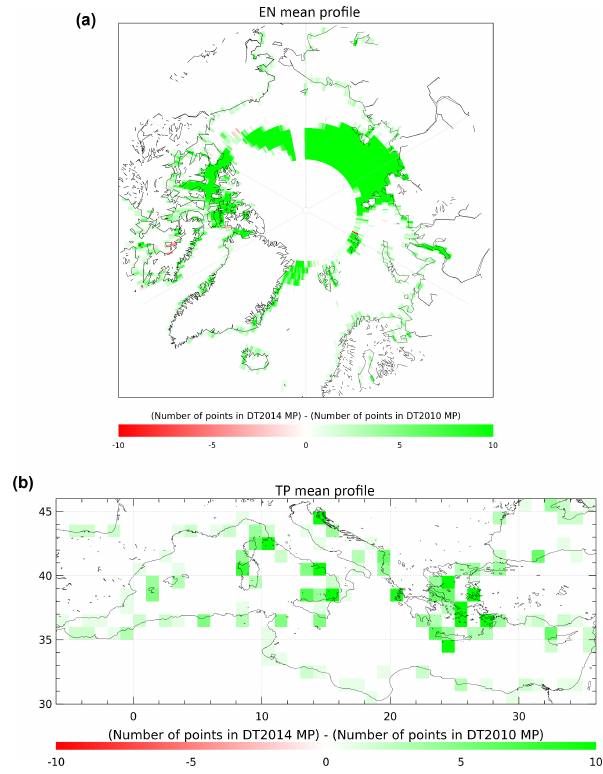
Figure 3. Differences in the number of points defined along the DT2014 and DT2010 versions of the mean profile defined along theoretical EN (a) and TP (b) tracks. Statistics done in 1 ◦ × 1 ◦